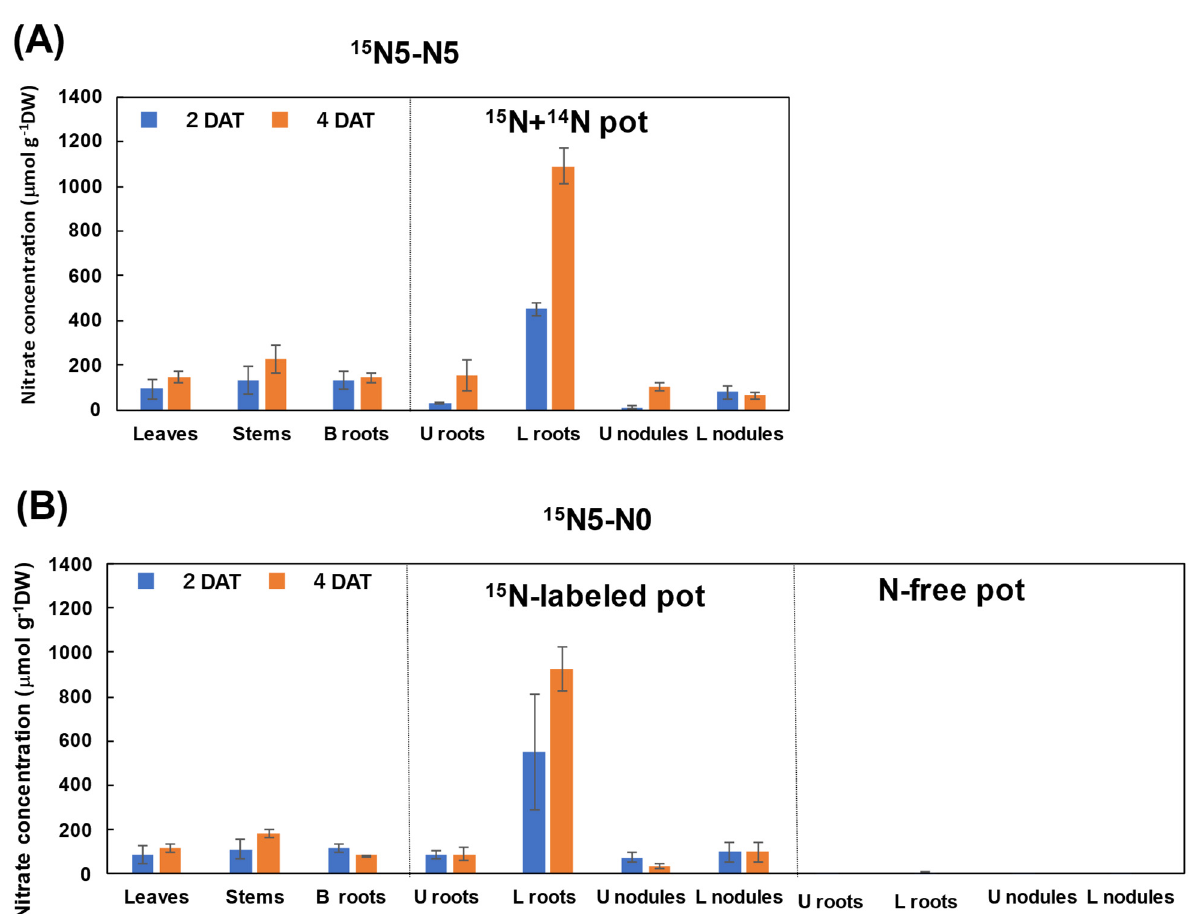
Figure 5. Nitrate concentration in each part of soybean with split-root treatments. ( A ) 15 N5-N5 treatment: The data of the roots and nodules in 15 NO 3 − and NO 3 − pots are shown. ( B ) 15 N5-N0 treatment: The data of the roots and nodules in 15 NO 3 − and those in N-free pots are separately shown. N = (4) ( A ) leaves, stems, and basal roots, and ( B ) roots and nodules, N = (8) ( A ) roots and nodules. Average ± SE.